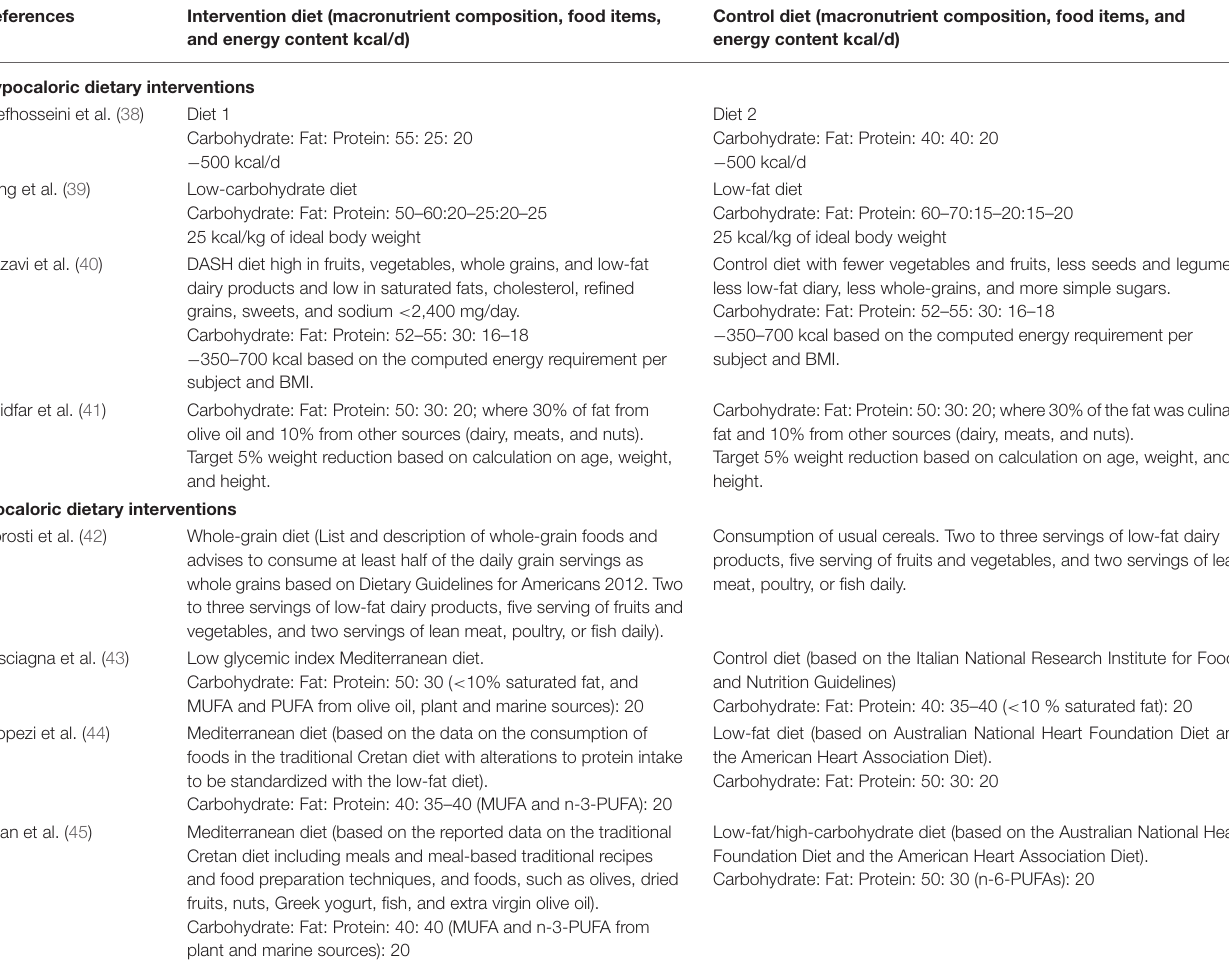
Control diet (macronutrient composition, food items, and energy content kcal/d)